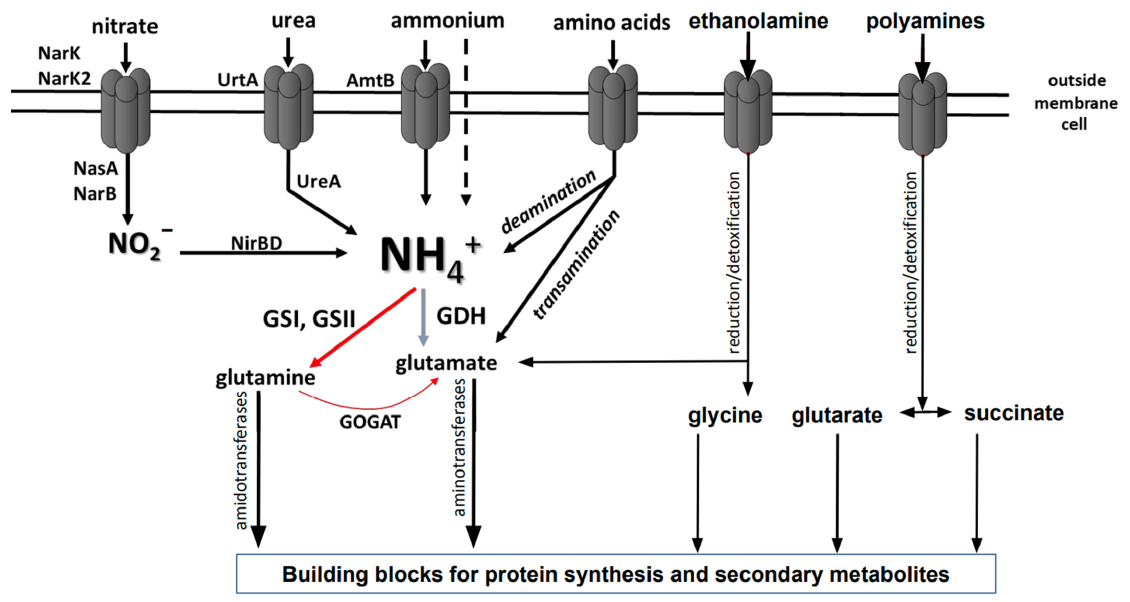
Figure 1. Schematic illustration of bacterial nitrogen metabolism. The main nitrogen sources, their uptake, and assimilation routes are depicted, as well as representative example of proteins involved in these processes. Enzyme systems for ammonia assimilation are shown in detail. GS: glutamine synthetase; GOGAT: glutamine-2-oxoglutarate-aminotransferase; GDH: glutamate dehydrogenase. Red arrows: GS/GOGAT pathway; light gray arrow: GDH pathway; black arrows: other metabolic routes; dark gray cylinders: transporters [5,6,16].